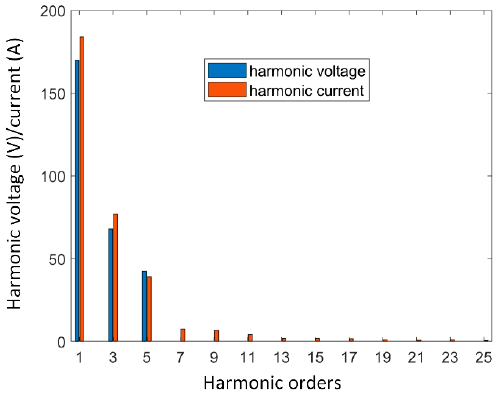
Figure 3. Harmonic voltage and current components in the ac side of the converter.